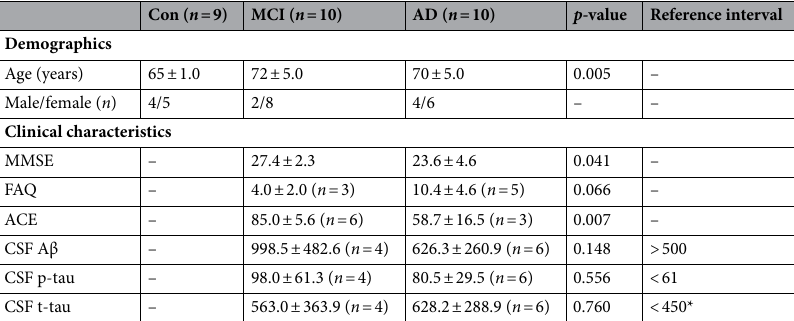
Table 1. Demographics and clinical information of study populations. All values are presented as mean ± standard deviation. Con healthy controls, MCI mild cognitive impairment, AD Alzheimer’s disease, MMSE Mini-Mental State Examination, FAQ Functional Activities Questionnaire, ACE Addenbrooke’s Cognitive Examination, CSF cerebrospinal fluid, Aβ Amyloid-β, p‑tau phospho-tau, t‑tau total-tau. *Interval for 51–70 years of age. For 71–90 years of age the interval is <